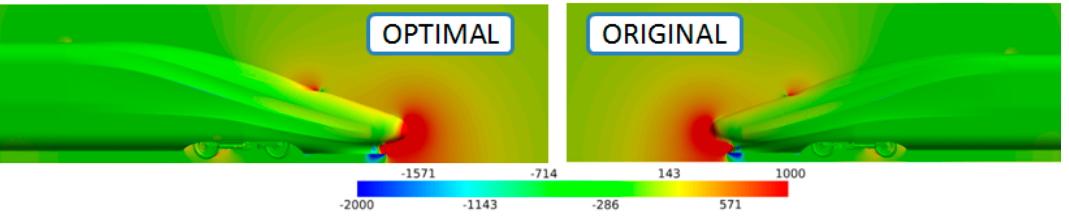
Figure 15. Pressure contour on the leading car before and after optimization (Pressure: Pa).